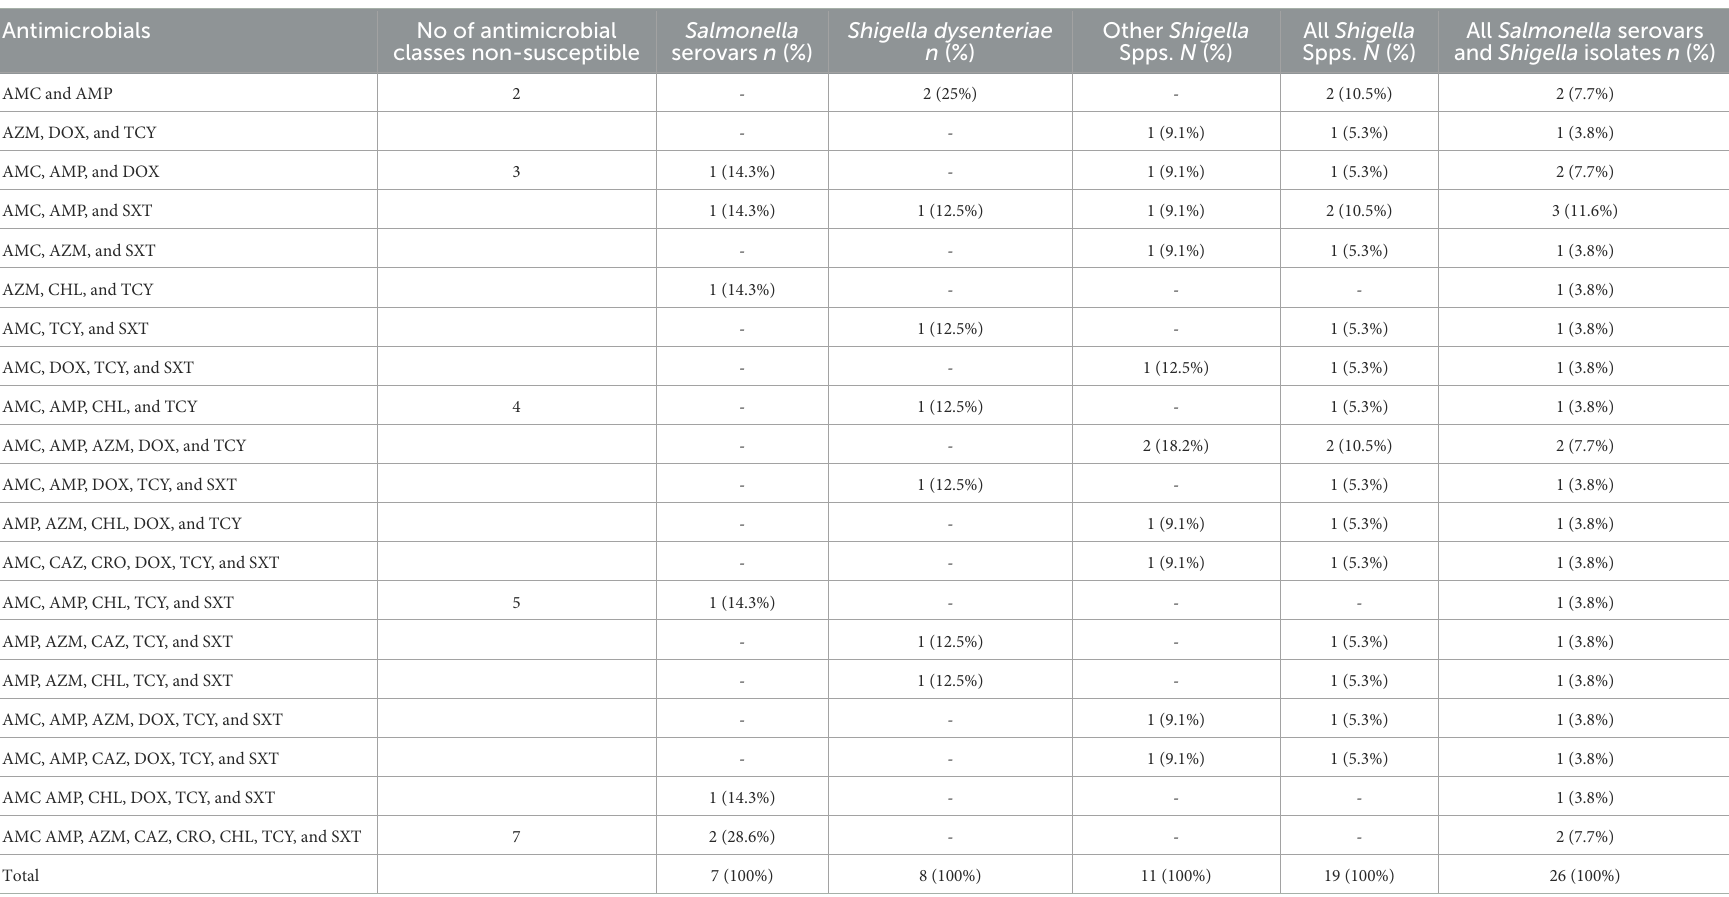
TABLE 5 MDR (resistant drugs combination) pattern of Salmonella and Shigella isolates from under-five diarrheic children in public health facilities in Debre Markos town, Northwest Ethiopia, 2022.